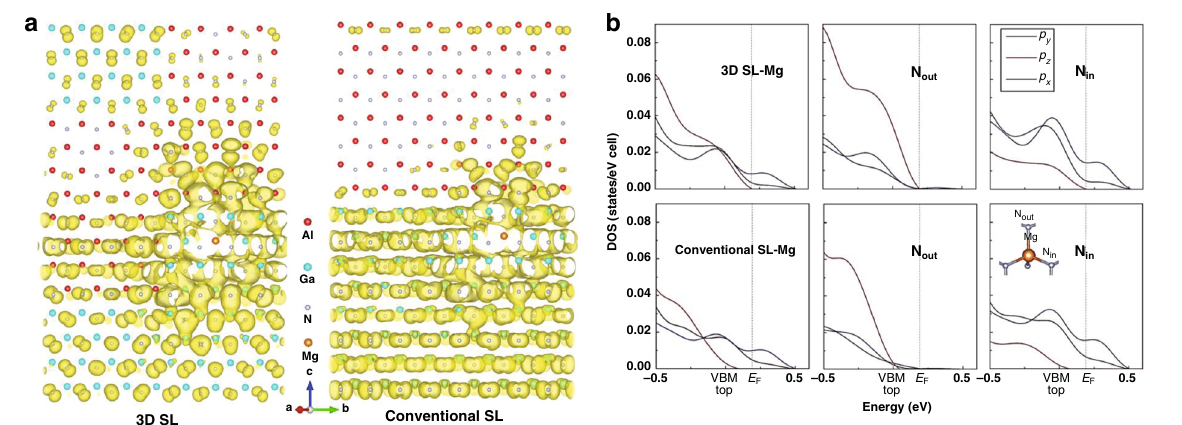
Fig. 12 The charge distribution (orbitals) at the top of valance bands in SLs structures. a The isosurface of the valence states at the top of valance bands for Mg-doped 3D and conventional GaN/AlN SLs with k vector restricted to [0001]. b Decomposed DOS of p x , p y , and p z of Mg and bonded N atoms in 3D SL and conventional SL. The N bonded with Mg lying in the ab plane and out of the plane is respectively denoted as N in and N out in the inset. Figures reproduced from ref. 156 , © 2016 Springer